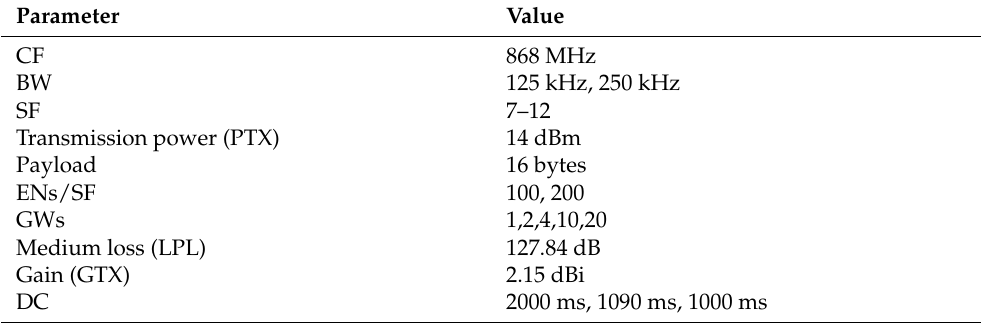
Table 2. Parameter selection.